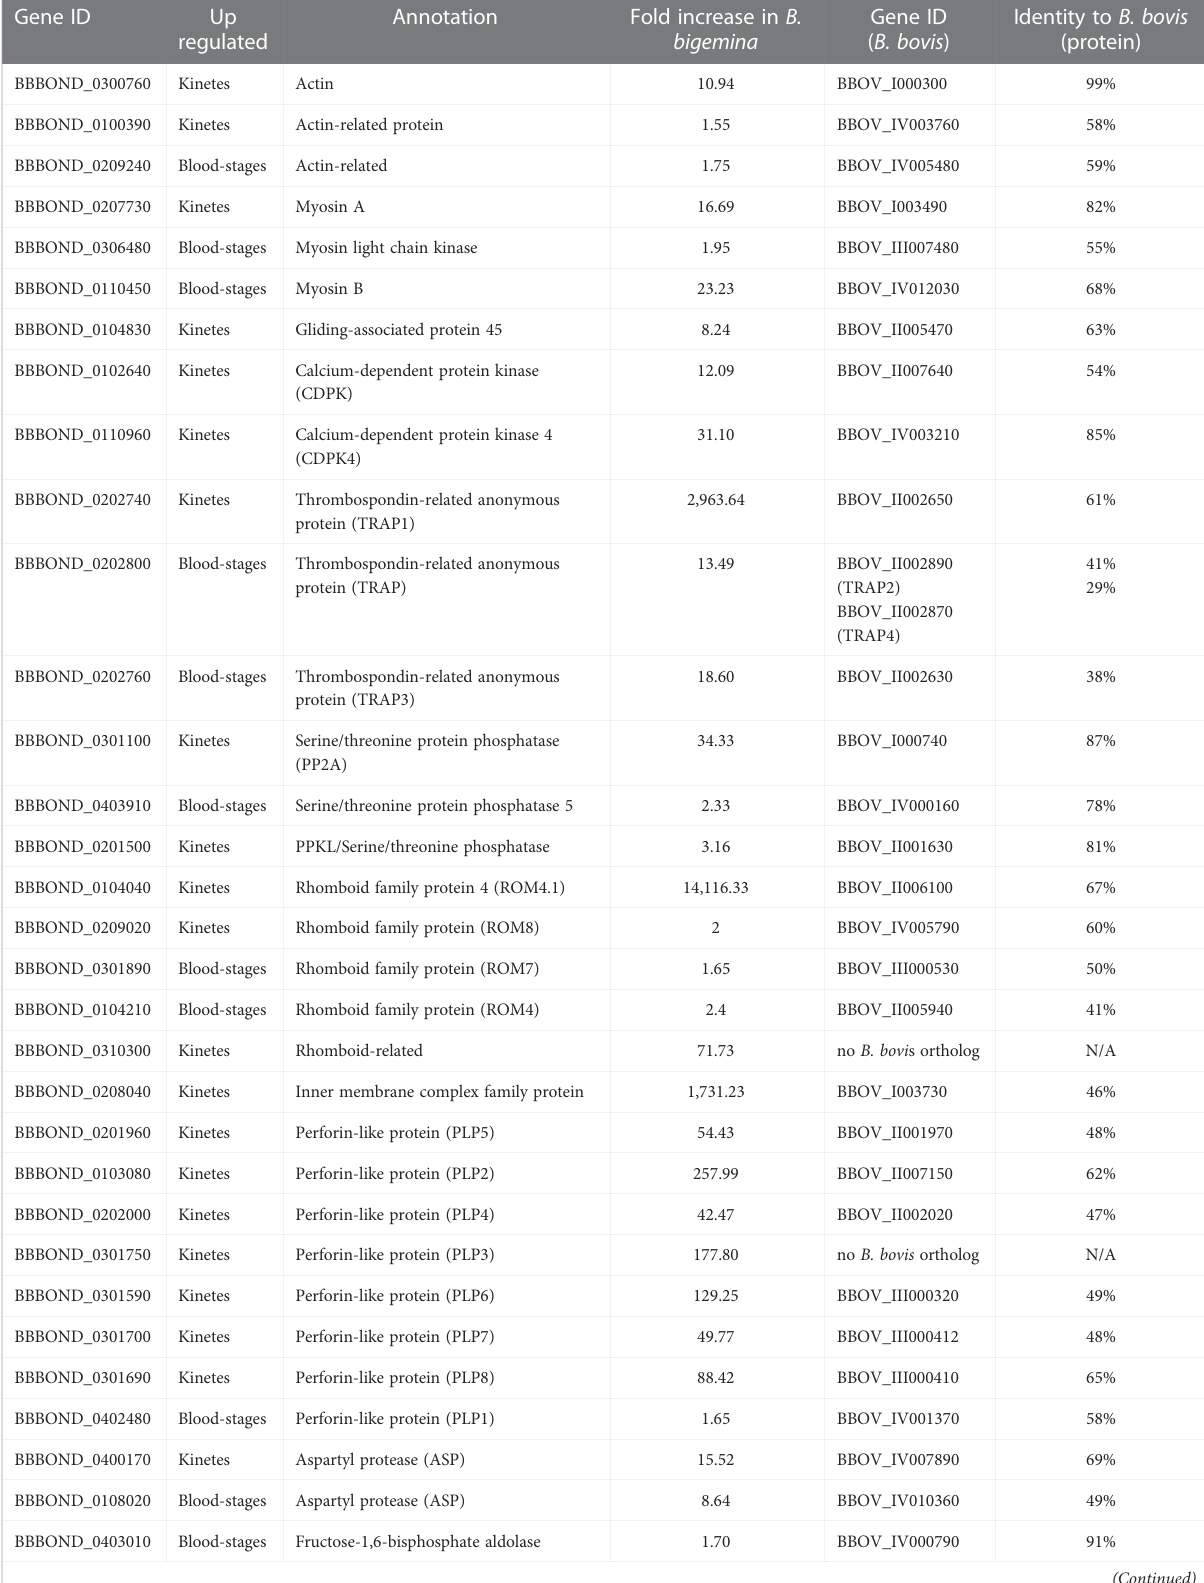
TABLE 8 Genes related with invasion and egress processes in B. bigemina kinetes and blood-stages. Gene ID Up Annotation Fold increase in B. regulated